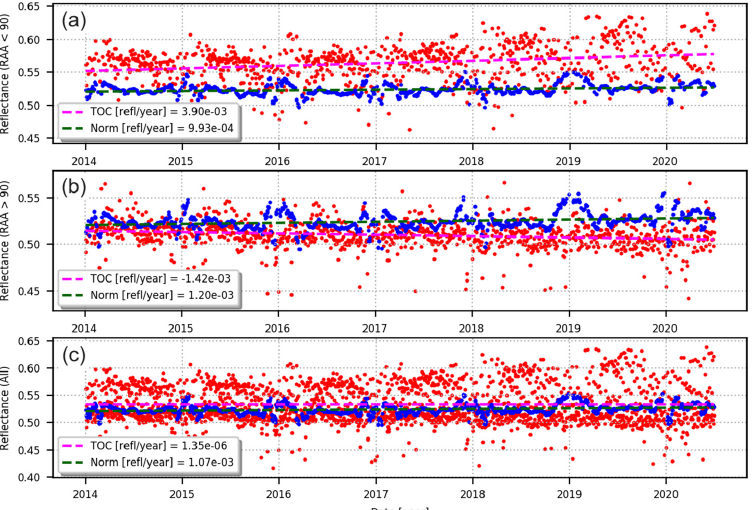
Figure 10. The figure shows TOC reflectance in NIR band for a bright desert site (Belmanip-207) located in Egypt (lat/lon = 27.87°/28.87°). The plots present the temporal series of TOC (red) and BRDF-normalized (blue) reflectances for three angular conditions: ( a ): RAA < 90°, ( b ) RAA > 90°, ( c ): “All”; the latter corresponds to retaining all observations in the fit. The fitted linear curves are also shown for TOC (purple) and BRDF-normalized (green) data with drift values reported in the